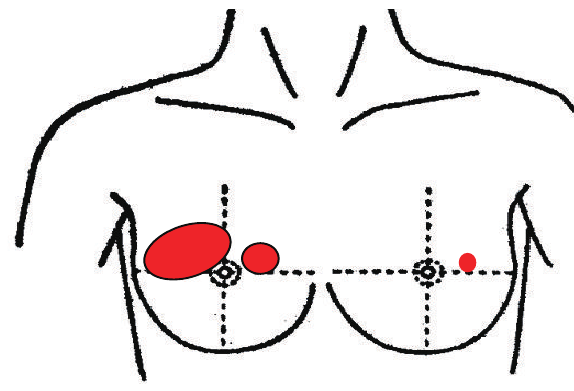
Figure 4: Histology of the breast tumor ( × 40). Many small lymphocytes infiltrated periducts with surrounding dense collagen fibers, accompanied by lymph follicles with germinal centers.